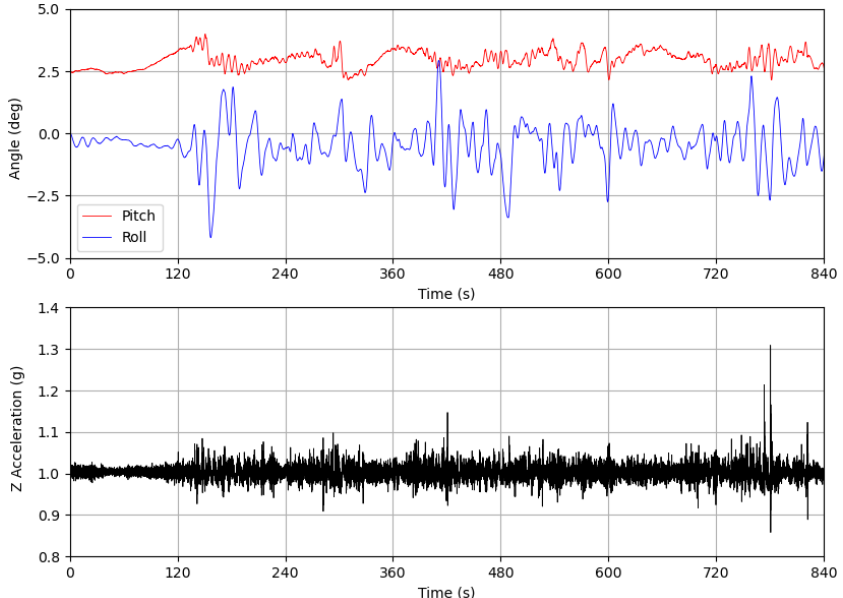
Figure 18. Pitch, roll and heave accelerations experienced by the ship during heavy-ice operations on 17 October 2019, in the time window of Figure 16.